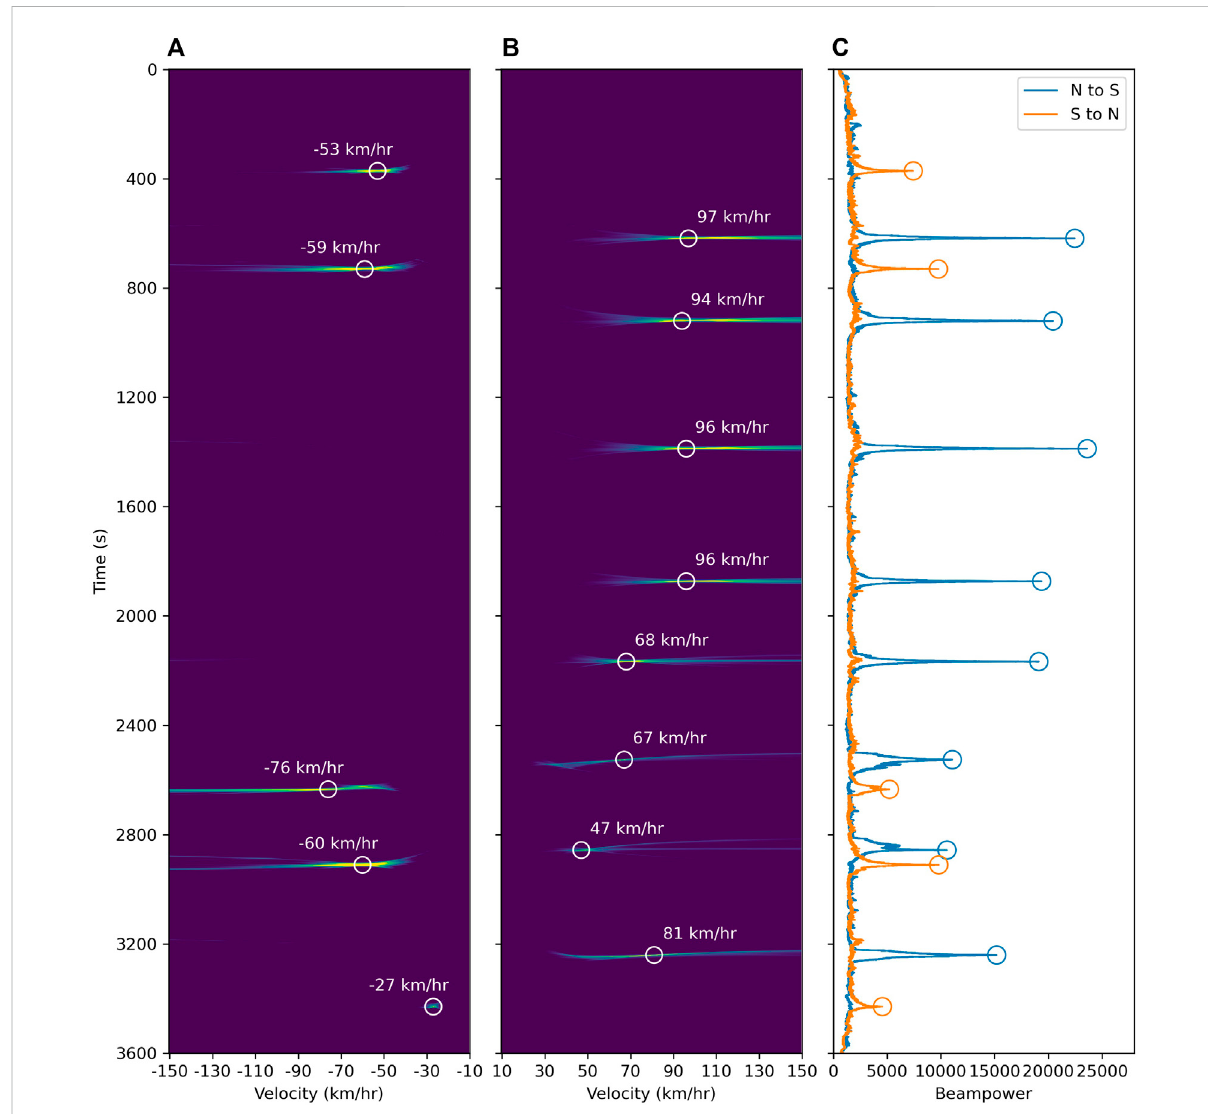
FIGURE 5 Beamformingresultsfora1-hdata(showninFigure2.). (A,B) Vespagrams forS-NandN-Strainsandlocalpowermaximumsdetectedfrom (C) ; (C) Time-beampower curve derived from (A,B) , detected peaks denoted as